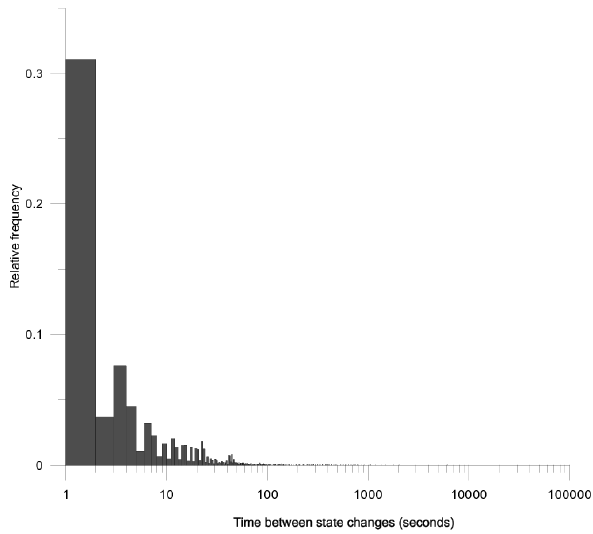
Fig. 6. Histogram showing relative frequency of sensor response Fig.6. Histogramshowingrelativefrequencyofsensorresponsetimes(i.e. offtoonandviseversa) times (i.e. off to on and vise versa).